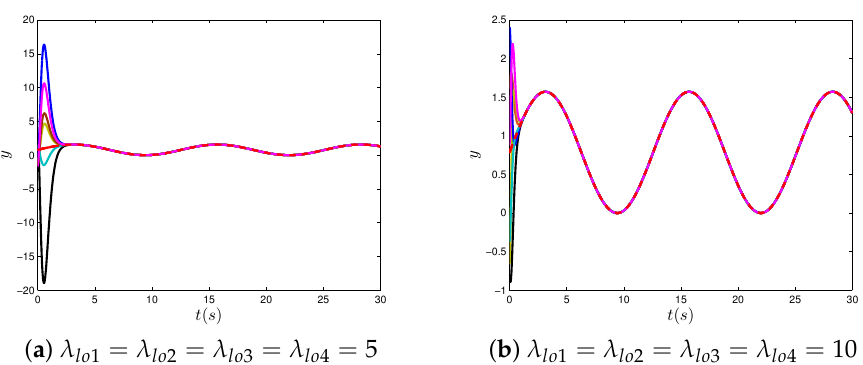
Figure 5. Tracking performance of ZD controller (21) with different model parameters values to solve the tracking control problem with the single-link manipulator with a flexible joints for the desired path y 1 d , s 1 = π sin ( t ) /4 + π /4. The various trajectories generated by distinct initial values are depicted by the diverse colored